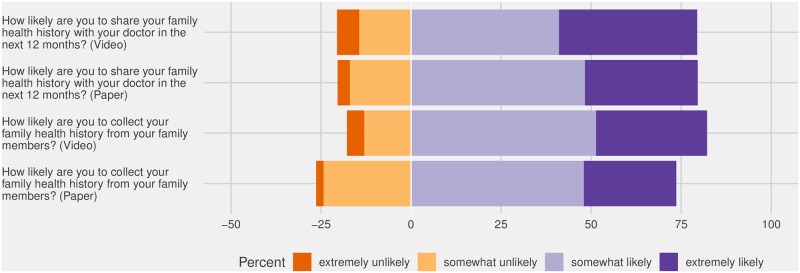
Likelihood of FHH collection and sharing post- educational intervention.